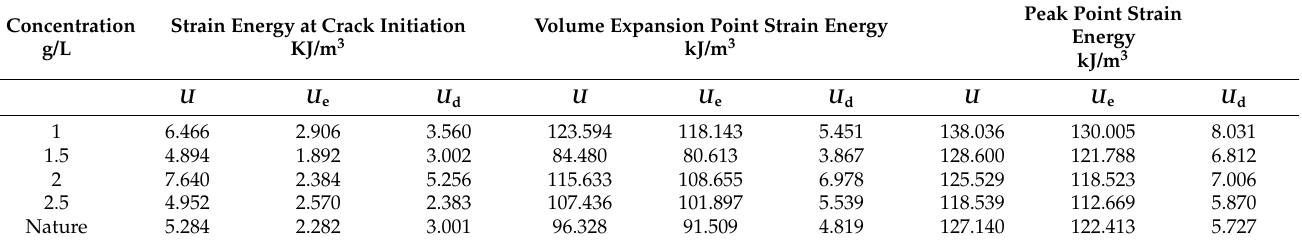
Table 4. Each characteristic point corresponds to the strain